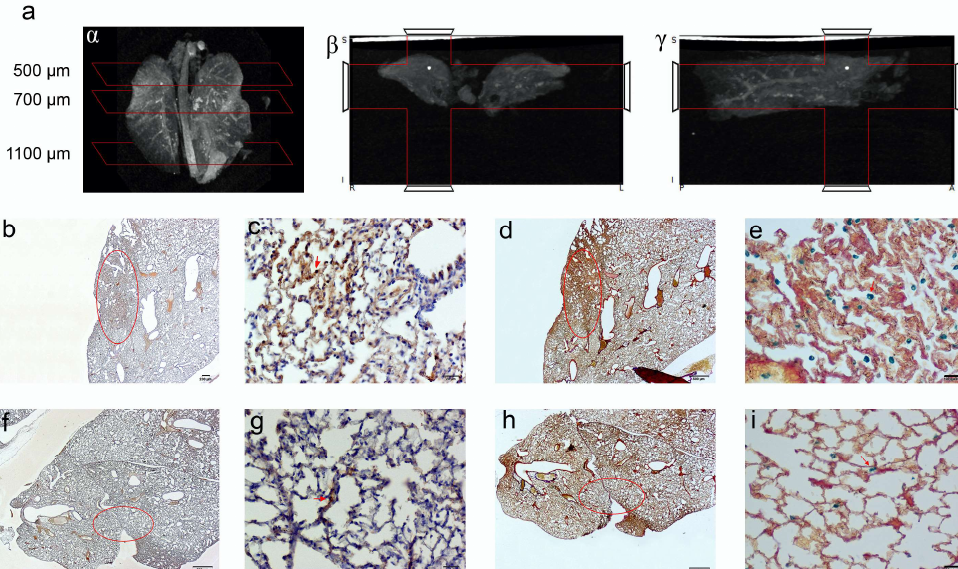
Figure 6. CT imaging of paraformaldehyde fixed lungs embedded in paraffin. The iron enrichment is visible in the corona ( a ) axial ( b ) and sagittal ( g ) plan images between 500 and 700 µm of the lung length due to the presence of EMHV accumulation. Immunohistochemical investigation ( b – i ) for the localization of the EMHV by magnetic force application identified by FHA and Spions contents reactivity on consecutive slides. ( b – e ) Reactivity in slides at 500 mm level; ( b ) The 20× magnification and ( c ) 40× magnification images of reactive FHA DAB immune-staining. ( d ) The 20× magnification and ( e ) 40× magnification of Perl‘s Prussian Blue reactivity of Iron particles. Less intense signals have been detected outside the magnetic field. ( f – i ) Immune reactivity measured at 700 mm level. ( f ) The 20× magnification and ( g ) 40× magnification images of reactive FHA DAB immunostaining. ( h ) The 20× magnification and ( i ) 40× magnification of Perl‘s Prussian Blue reactivity. The red circles in ( b , d , f , h ) correspond to the stained area showed in ( c , e,g,i ) pictures. Absence of reactivity was detected at 1100 mm (Perl’s Prussian Blue staining Supplementary Figure S3).